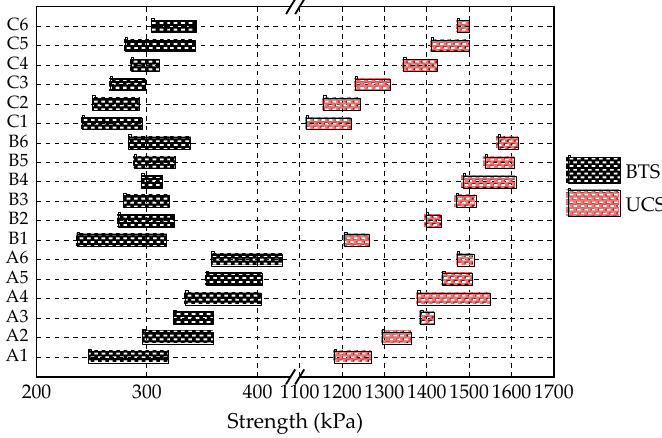
Figure 5. Strength for soil modified by the improved EICP containing organic material.